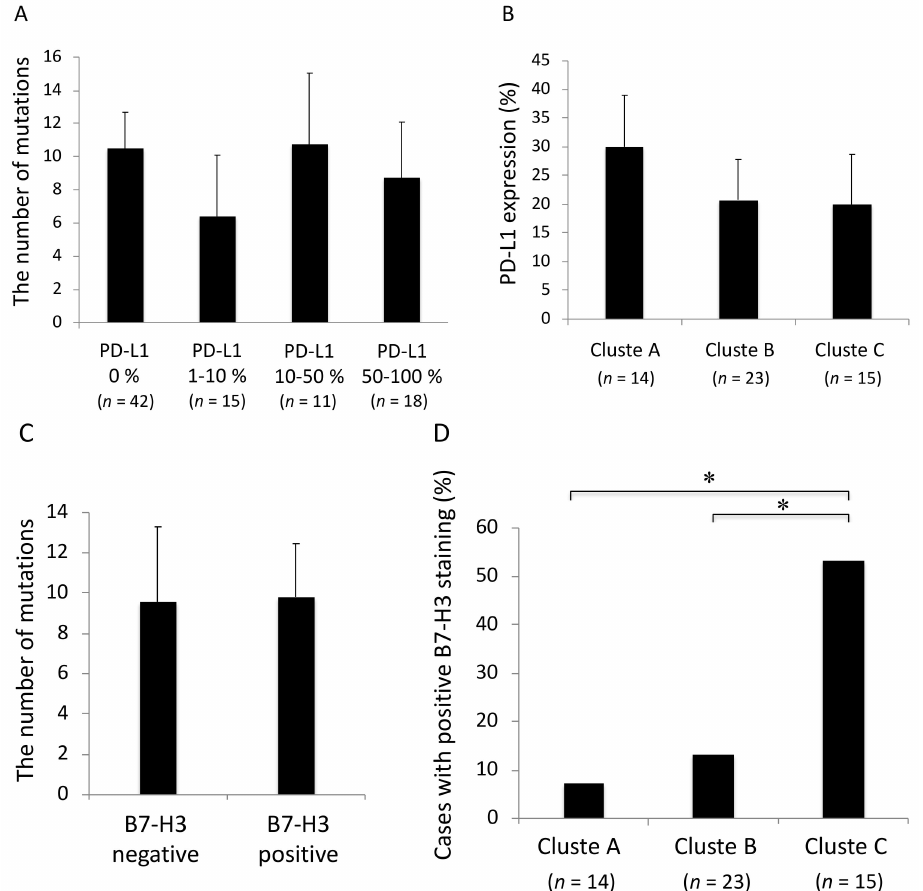
Figure 4. Association between the mutation profiles and PD-L1 expression. ( A ) Estimates of tumor mutation burden and PD-L1 expression. The number of mutations detected by targeted sequencing was not significantly different among the cancers with different PD-L1 expressions ( p = 0.79). ( B ) Comparison of PD-L1 expression among the genomic clusters of cancer. PD-L1 expression was not significantly different among the clusters A, B and C ( p = 0.81). ( C ) Estimates of tumor mutation burden and B7-H3 expression. The number of mutations detected by targeted sequencing was not significantly different between the cancers with and without B7-H3 expressions ( p = 0.86). ( D ) Comparison of B7-H3 expression among the genomic clusters of cancer. B7-H3 expression was significantly elevated in the cluster C compared with the clusters A and B. *, p <